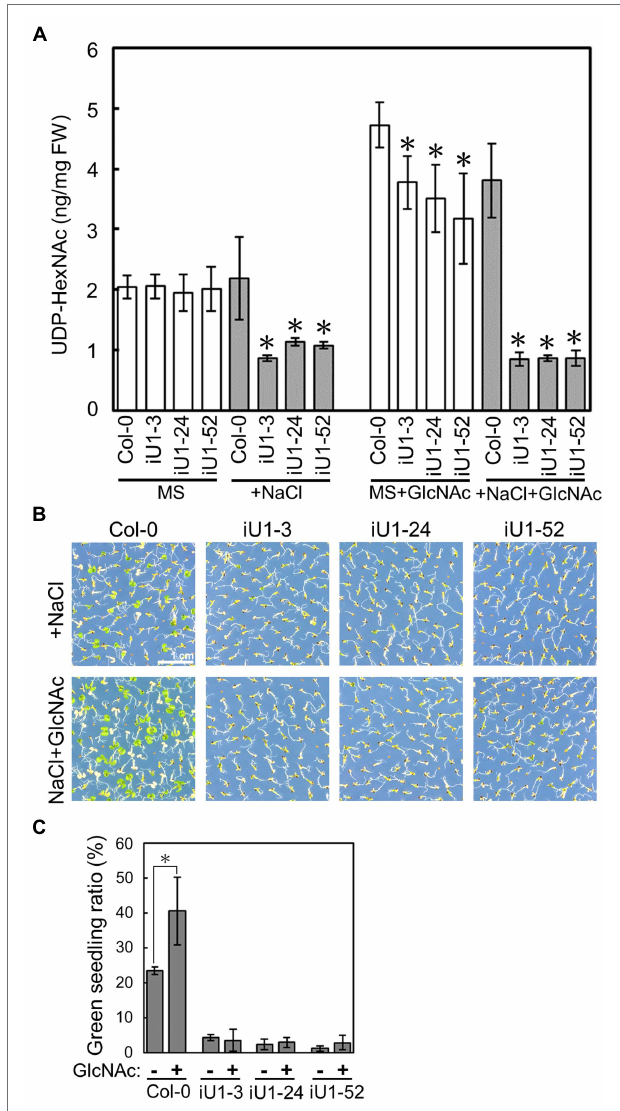
FIGURE 3 | Reduced contents of UDP-N-acetylhexosamines (UDP- HexNAc) in salt-treated iU1 seedlings. (A) Reduction in UDP-HexNAc in iU1 seedlings. UDP-HexNAc was analyzed by LC/MS from 14-day-old seedlings grown on MS agar media supplemented with or without NaCl (200 mM) or NaCl + GlcNAc (100 μ M). Data represent the means ± SD of four biological replicates. * p < 0.05. Student’s t -test. (B) Phenotypic comparison. Seedlings were grown under the same conditions as those shown in (A) . (C) Seedlings with greening cotyledons in (B) were quantified. Data represent the means ± SD of at least four biological replicates, each with 60–80 seeds. * p < 0.05, Student’s t